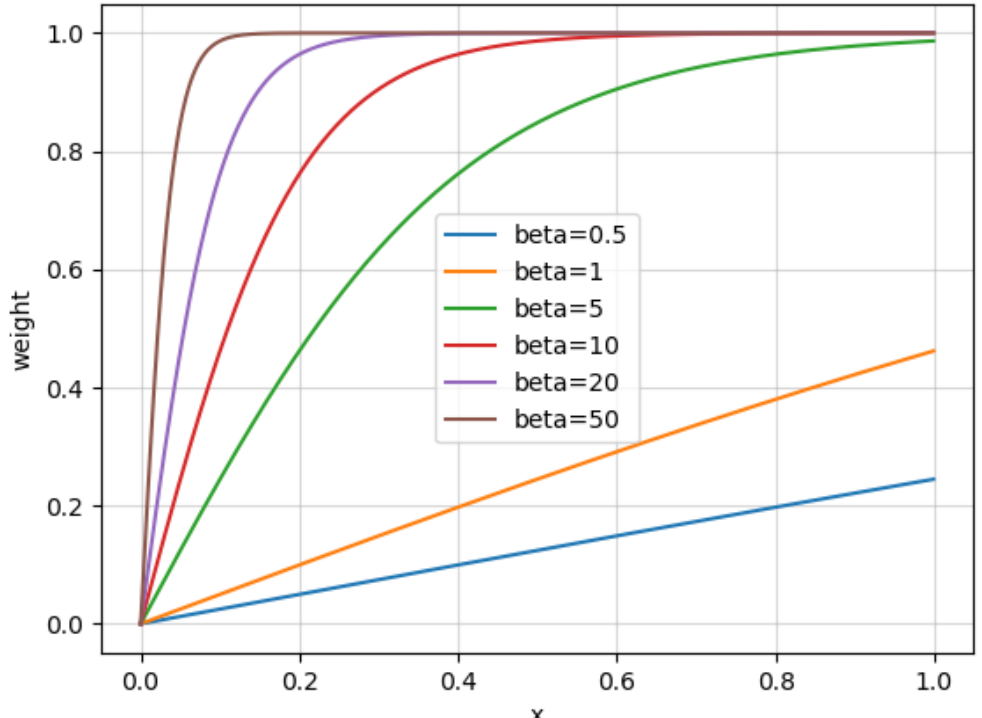
Figure 5. The influence of hyperparameter β on the change speed of the weight w with regard to the current size proportion x